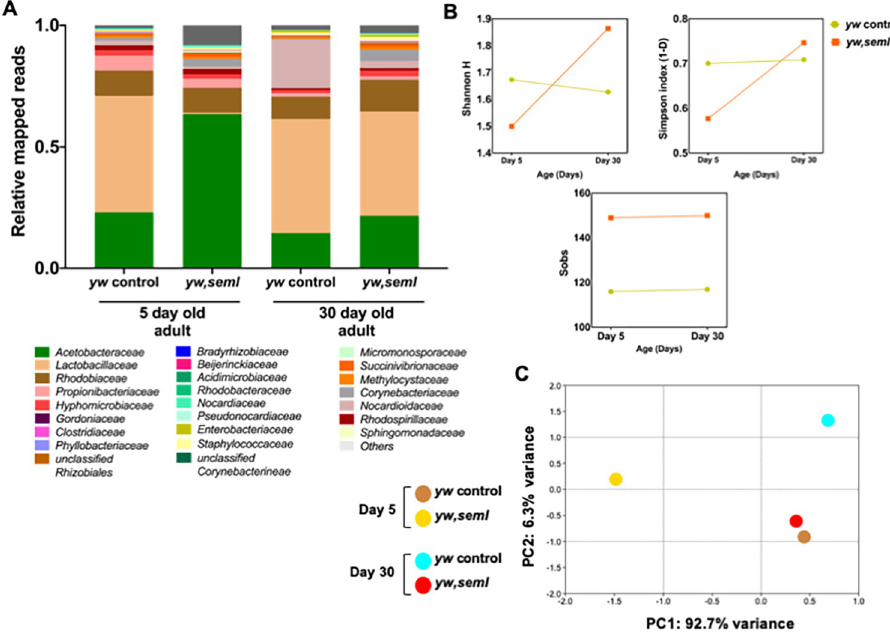
Fig 2. Loss of PGRP-SA changes intestinal bacterial composition in young flies. (A) The graph represents the relative abundance of bacterial families observed in the gut of 5 - day and 30-day old female yw , ywseml flies revealed by 16S next-generation sequencing. The x axis represents y strains of different ages, and the y axis represents relative mapped reads. (n = 40 guts/strain). (B) The graphs represent alpha diversity indices of female yw and yw seml across two ages (5 and 30 days). (A) Simpson’s (1-D) index, (B) Shannon H index an (C) Total number of bacterial families observed (Sobs). R represents biological repeat. (n = 40 guts/strain). (C) The graph represents PCA plot (Beta diversity) of female yw and yw seml across two ages (5 and 30 days). R represents biological repeat (n = 40 guts/strain).